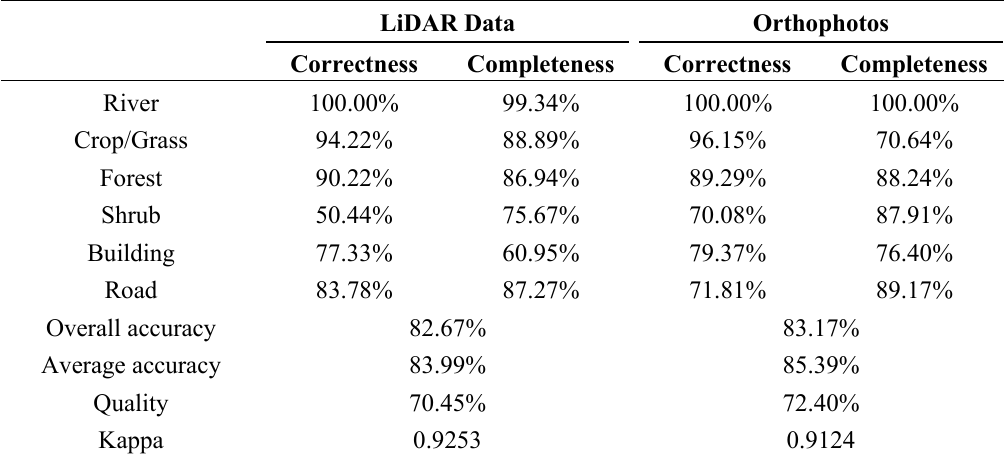
Table 5. Accuracy assessment for LULC